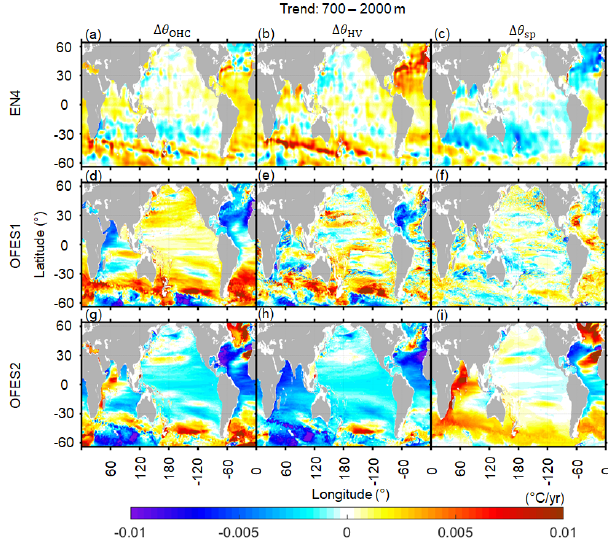
Figure 16. As for Fig. 14 but for the lower layer (700–2000m).